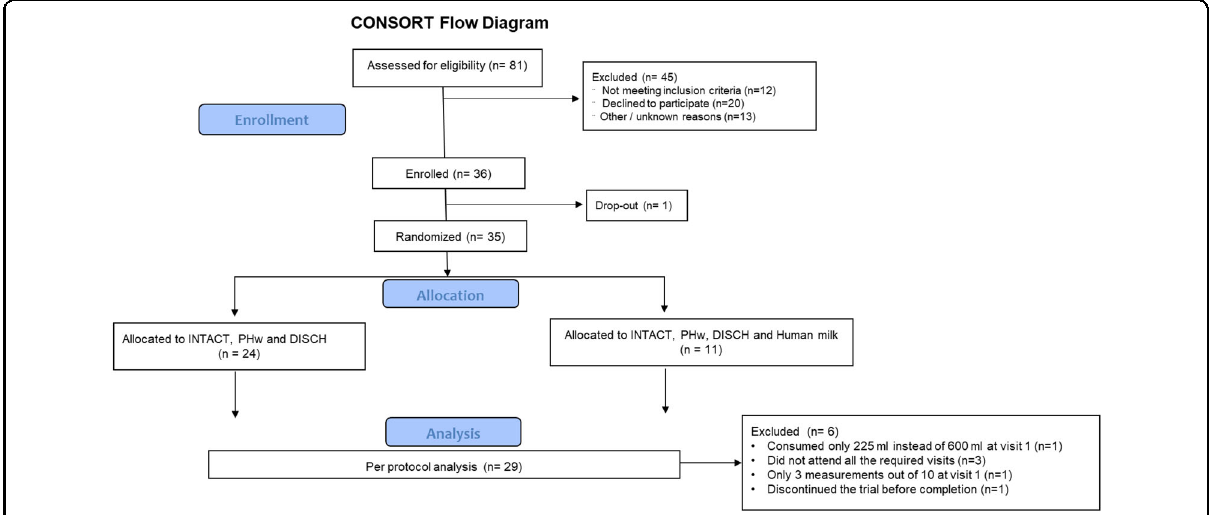
Fig. 1 Details of participant enrolment, allocation and inclusion in the study analysis illustrated in a Consort fl ow diagram.